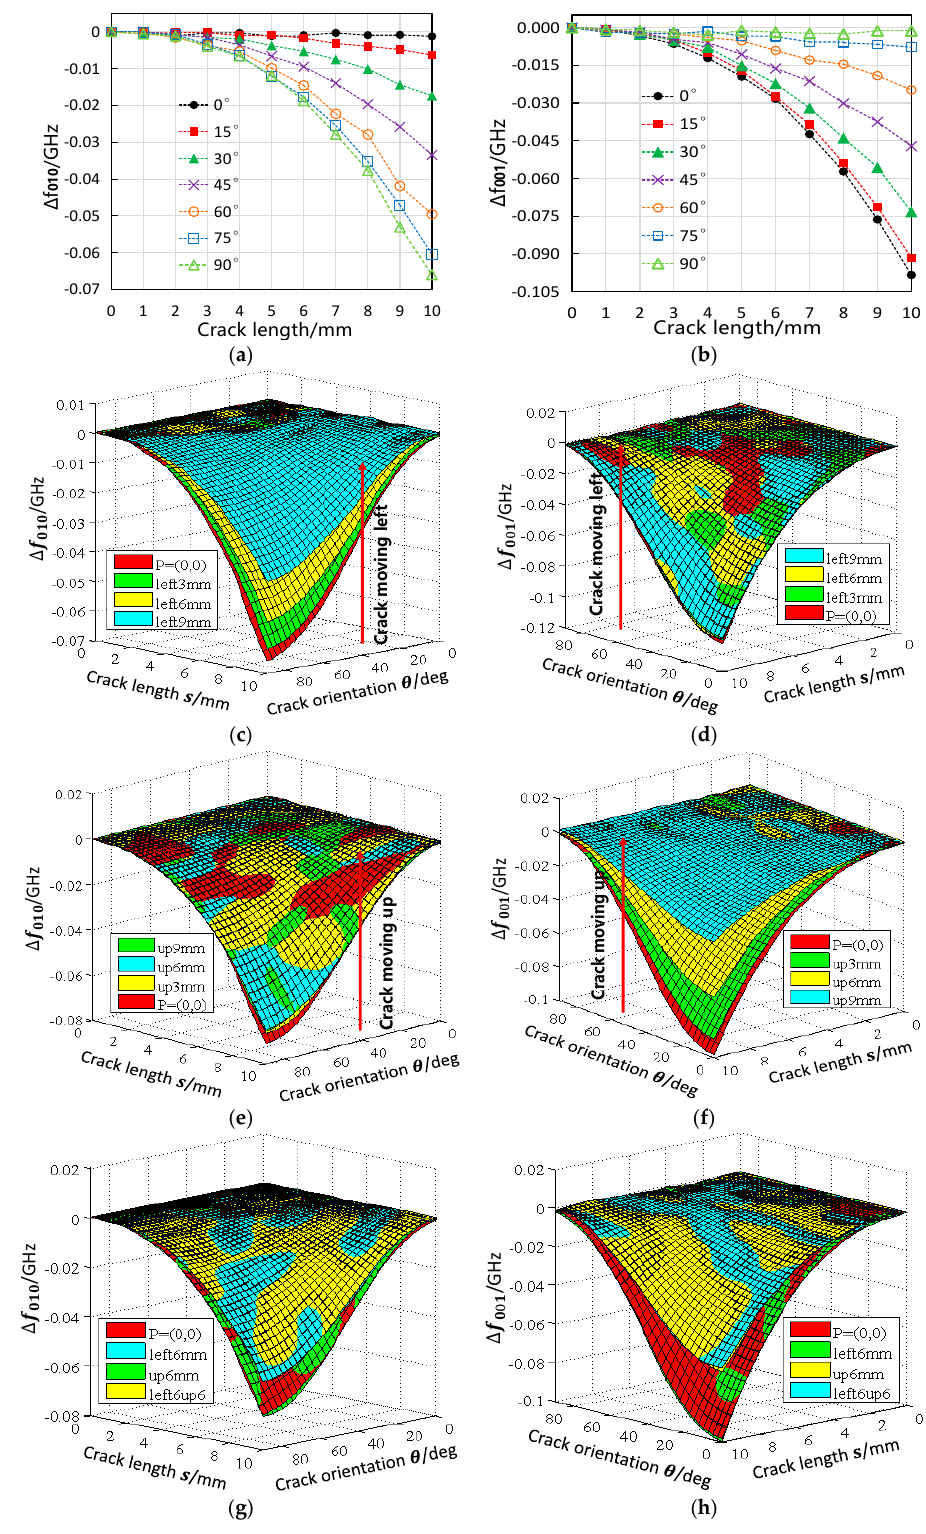
Figure 5. Simulated results. ( a ) f 010 and ( b ) f 001 response to cracks at the center of the ground plane; ( c ) f 010 and ( d ) f 001 response with the crack position moving leftwards; ( e ) f 010 and ( f ) f 001 response with the crack position moving upwards; ( g ) f 010 and ( h ) f 001 response with the crack position moving leftwards and upwards